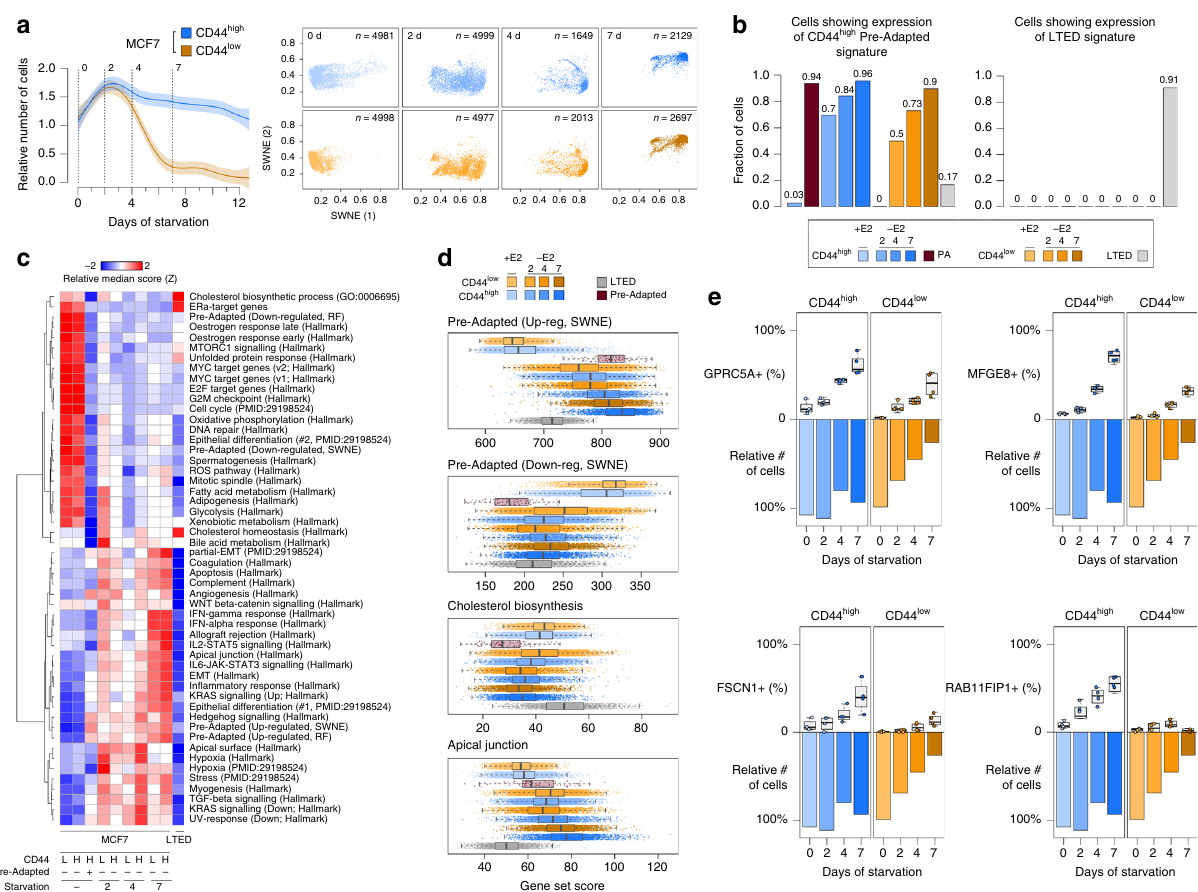
Fig. 6 Features of pre-adaptation persist in acute-ET, but not in full resistance. a Sampling design along with dimensionality reduction of single-cell transcriptional pro fi les of E2 supplemented (day 0) or deprived (days 2, 4 and 7). b AUCell 39 quanti fi cation of the fraction of single-cells showing transcriptome compatible with either the pre-adapted (left) or the LTED (right) signatures. c Selected gene set enrichment across all conditions pro fi led in this study. d Score distributions for the indicated gene sets, across cells. e Multi-marker tracing pro fi les for selected genes (box plots) in CD44 high and CD44 low cells upon E2 deprivation. Survival (as relative number of residual cells) is also shown (bar plots). Box plots show median, interquartile values, range and outliers (individual marker genes (namely, GPRC5A, MFGE8, FSCN1 and RAB11- FIP1) showing a trend of upregulation with starvation time. This